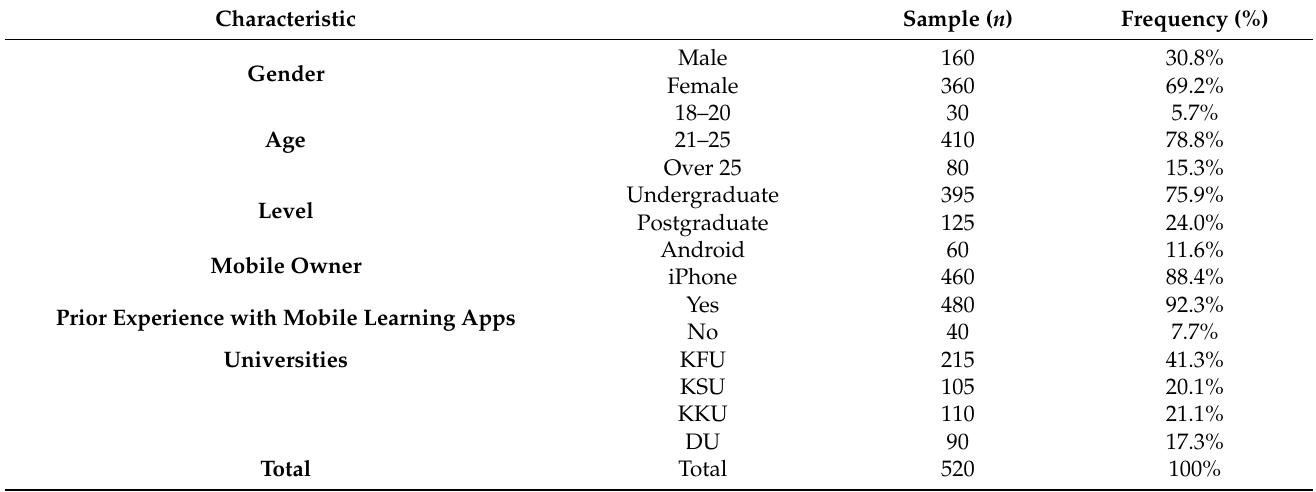
Table 1. Analysis of demographic